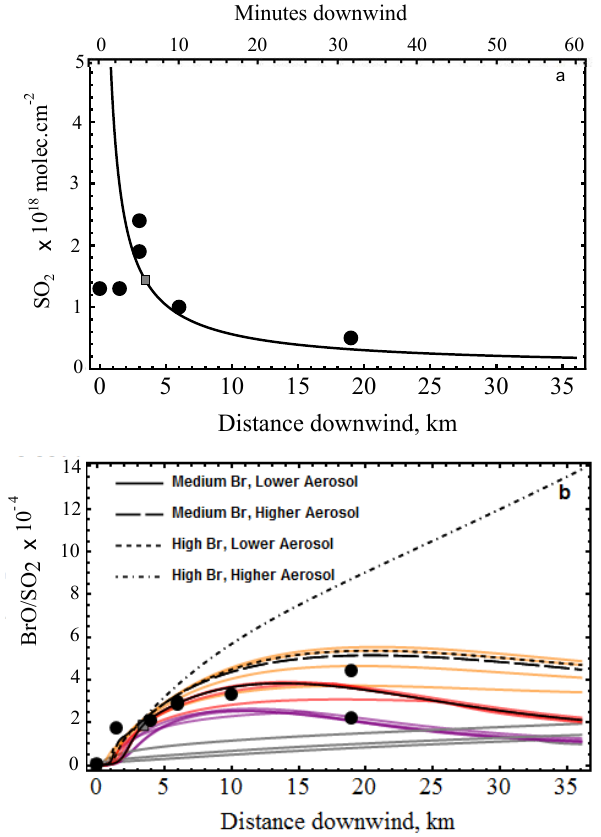
Figure 1. PlumeChem simulations illustrating (a) predicted SO 2 column abundance in the downwind plume (black line) according to the model dispersion parameterisation, (b) simulated downwind BrO/SO 2 ratios for model runs using this dispersion parameter- isation but where bromine in the emission (Br tot /SO 2 ) , volcanic aerosol loading and the high-temperature initialisation are varied. The simulations are compared to DOAS SO 2 column abundances and (mean) BrO/SO 2 ratios reported by Oppenheimer et al. (2006), and Bobrowski et al. (2007), grey squares and black discs, respec- tively. Simulations with varying aerosol emission (for two bromine scenarios) are highlighted in black. Simulations assuming medium aerosol loading and varying bromine emission (for a range of plausi- ble high-temperature model initialisations) are shown in red, orange and purple for medium, high and low Br emission scenarios, re- spectively. Simulations assuming no plume–air mixing in the high- temperature initialisation ( V A : V M = 0:100) are shown in